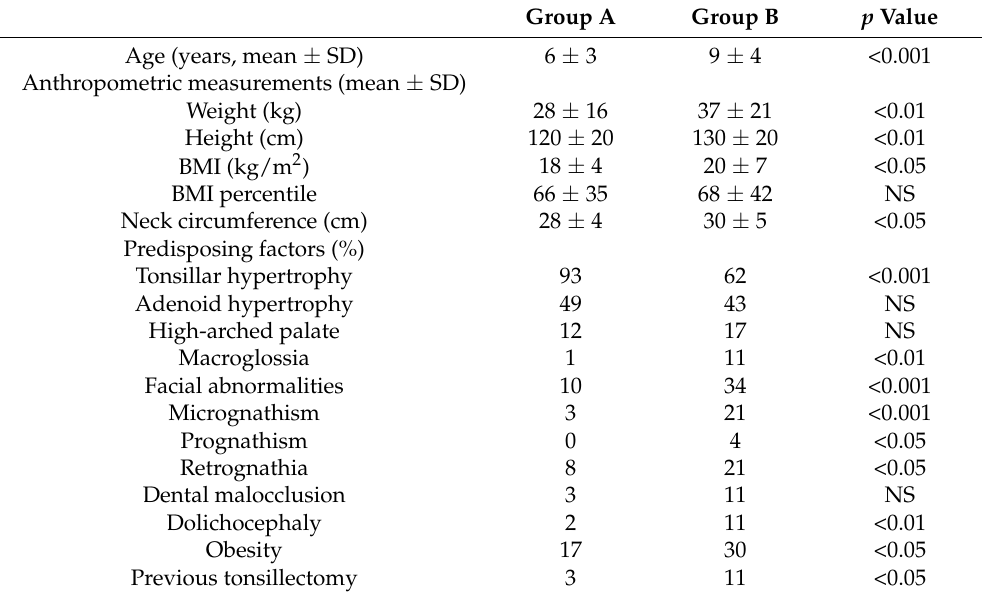
Table 1. Comparison of age, anthropometric measurements and predisposing factors for sleep ap- nea–hypopnea syndrome in Groups A and B.